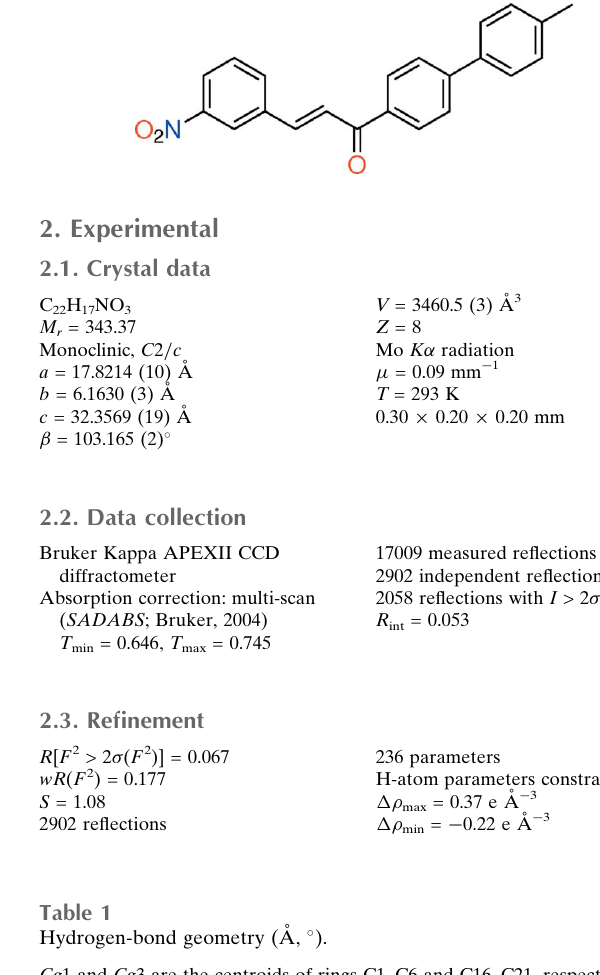
Hydrogen-bond geometry (A˚ , (cid:3)